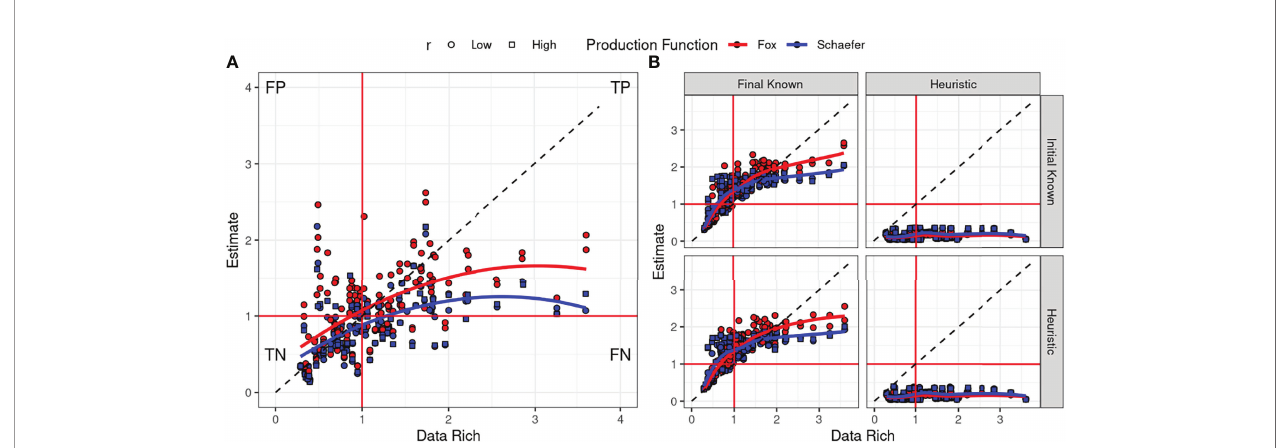
FIGURE 2 | Comparisons of estimates of B:B MSY in the fi nal year with the data-rich (i.e. RAM legacy DB) values. The biomass dynamic assessment model with the index of abundance estimates are shown in panel (A) , and the catch-only model values in panel (B) If the biomass assessment with index was unbiased y = x. True positive (TP) is when a prediction and the actual value are both positive; false positive (FP) is when a prediction is positive the actual value is negative; true negative (TN) is when where the prediction and actual value are both negative; and false negative (FN) is when the prediction is negative and the actual value is